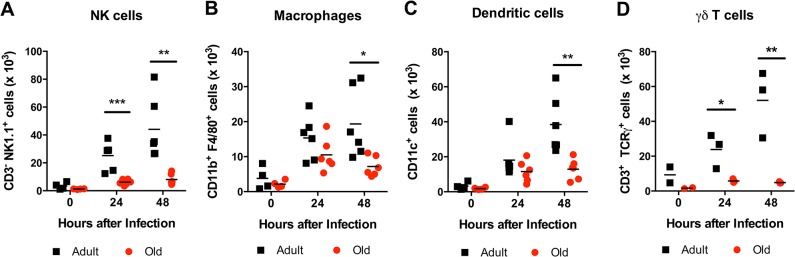
Leukocyte infiltration in the DLN of WNV-infected adult and old mice.Adult and old mice were infected with 102 PFU of WNV (New York strain) in the footpad. One or two days later, the draining popliteal LN was harvested, cells were stained with antibodies to detect specific cell populations including (A) NK1.1+ NK cells, (B) CD11b+ F4/80+ macrophages, (C) CD11c+ dendritic cells, and (D) γδ T cells. The results are depicted as a scatter plot and are pooled from two independent experiments with a total of 6 mice per group (with the exception of γδ T cells, which reflects 3 mice per group). Asterisks indicate statistical significance (*, P < 0.05; **, P < 0.01; ***, P < 0.001; Mann-Whitney test).